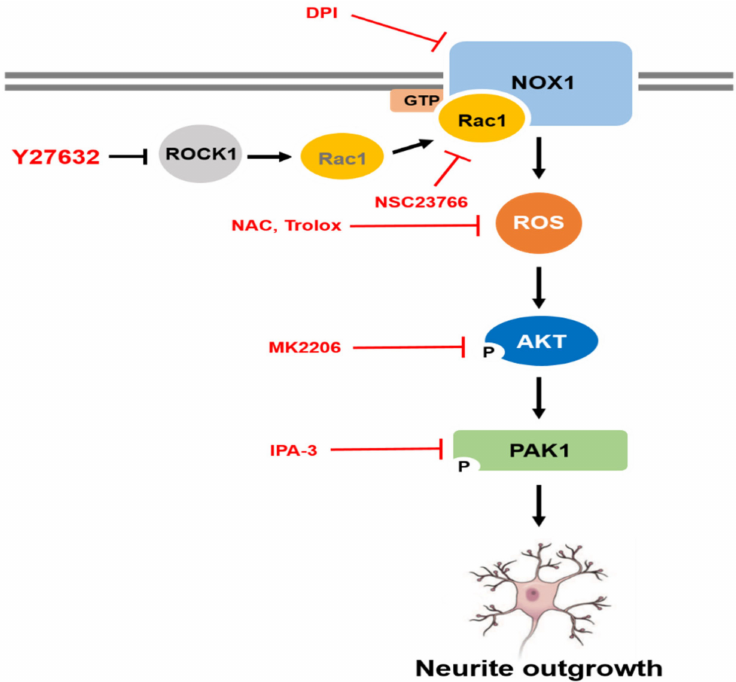
Figure 6. Schematic representation of Y-27632-induced neurite outgrowth in PC12 cells. Y-27632 causes Rac1 activation and leads to NOX1-mediated ROS generation. ROS then subsequently activate AKT and PAK1, which results in neurite outgrowth in PC12